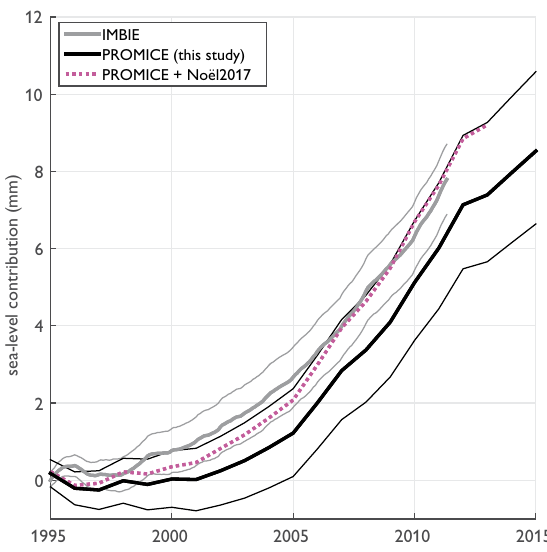
Fig. 5. Cumulative sea-level equivalent (SLE) contribution from this PROMICE study shown in comparison to the Greenland Mass Balance Inter-Comparison Exercise (IMBIE; Shepherd et al. 2012). As IMBIE surveys both the ice sheet and peripheral glaciers, we also sum this study with the independent peripheral glacier contribution estimate of Noël et al. (2017) for